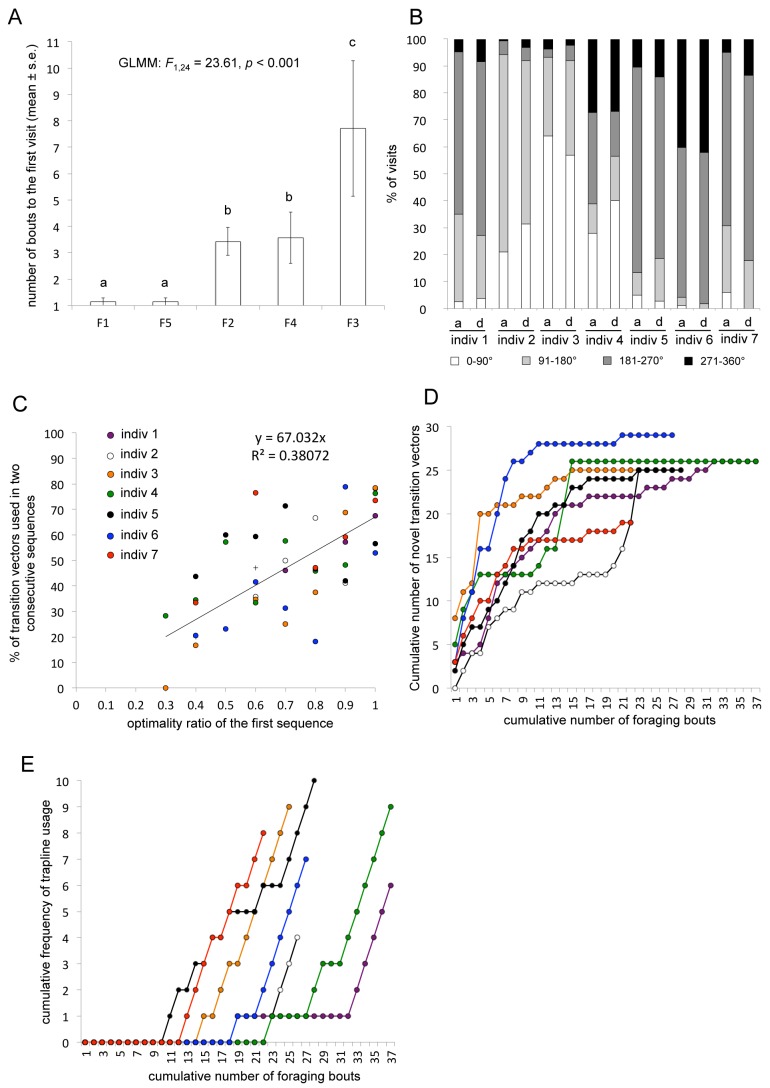
Trapline development in the initial pentagonal array of flowers.(A) The average number of foraging bouts (mean ± s.e.m., n = 7 bees) before a bee made its first visit to each flower (F1–F5). Letters above columns indicate significant differences (GLMM, effect of flower on the number of bouts, t test: p<0.05). (B) Proportion of arrivals (a) and departures (d) made by each bee in the four quadrants (90° sectors) of the landing platform on all flower visits. (C) Proportion of transition vectors (either nest-flower, flower-flower, or flower-nest) repeated in two successive bouts in relation to the optimality ratio (straight line length of the observed visitation sequence divided by the straight line length of the shortest possible sequence to visit the same number of flowers) of the first bout. (D) Cumulative frequency of different transition vectors experienced in relation to the cumulative number of foraging bouts completed. Each bee used on average 25±1.13 different vectors (mean ± s.e.m., n = 7 bees) out of a total of 30 possible. (E) Cumulative frequency of trapline usage (the most common five-flower visitation sequence, excluding revisits, used by each bee) in relation to the cumulative number of foraging bouts completed. Traplines were first observed between bout 11 and 23, and became stabilized (used in at least three consecutive bouts at the end of training) in six bees between bouts 24 and 35. Labels 1–7 refer to the same individuals in all figures and tables.